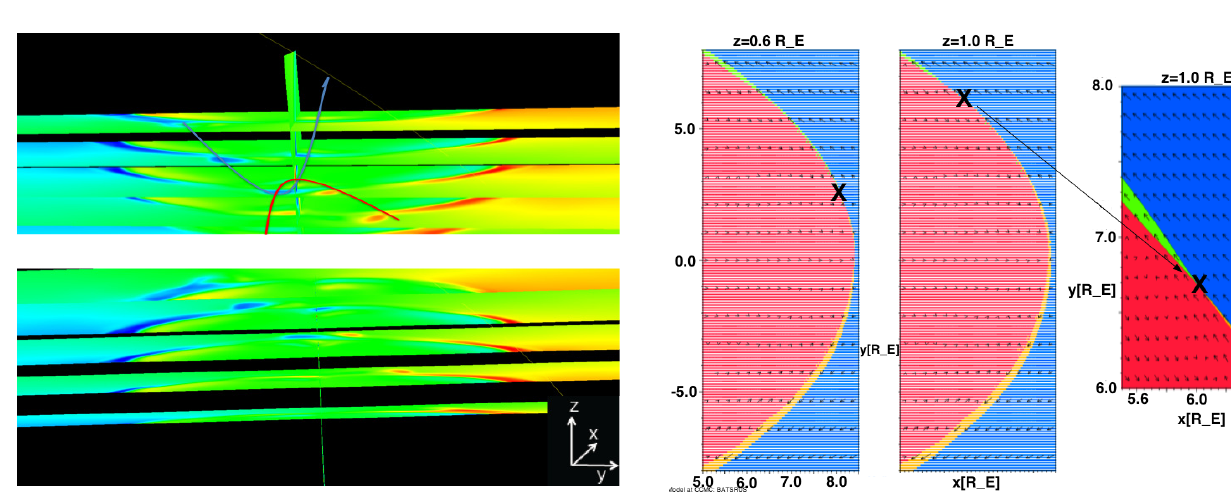
green at y = 0 . 8 to 1 R E and the yellow at y = − 1 to −